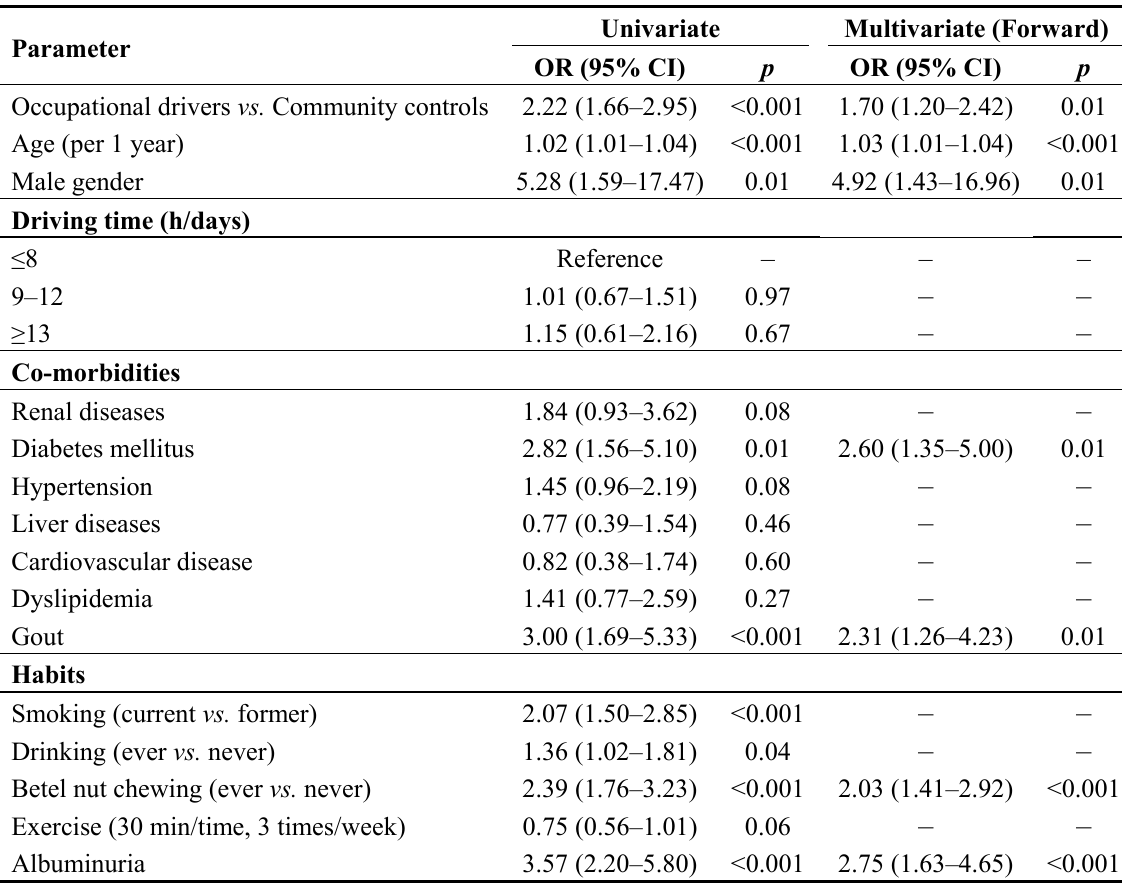
Table 2. Determinants of MetS in all